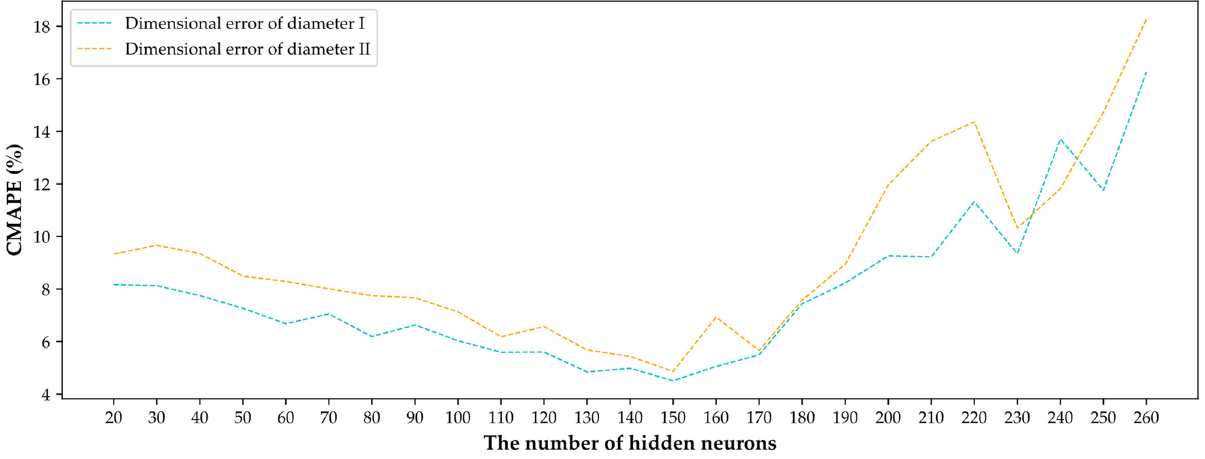
Figure 9. The performance of hidden neuron number on the testing set.